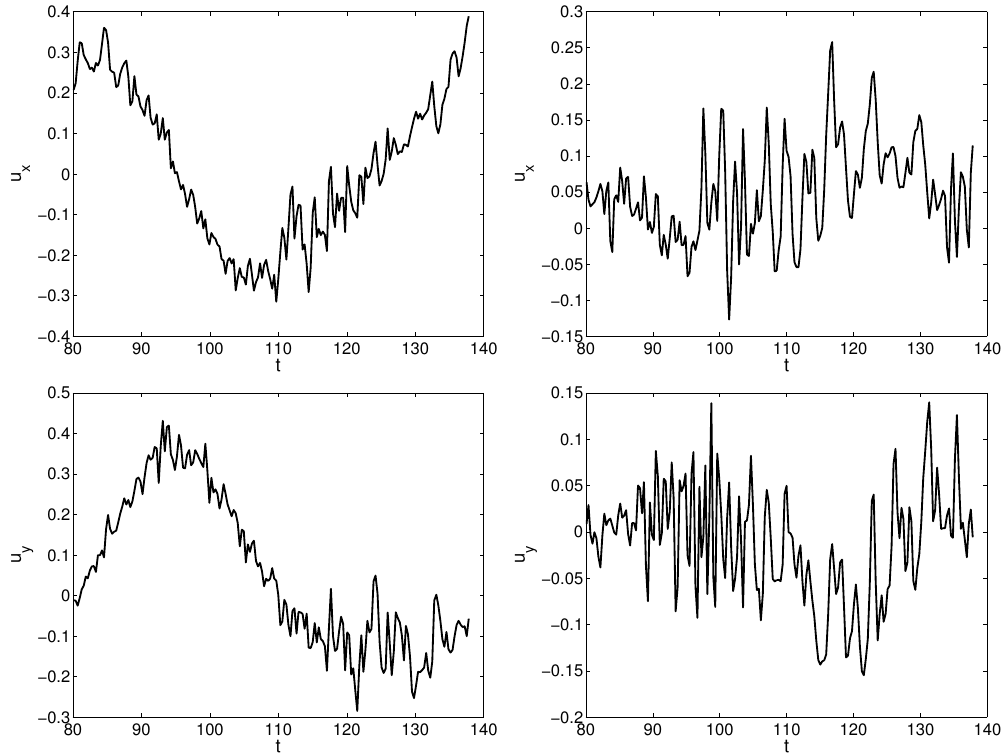
Figure 9. Counterpart of Figure 4 in the three-blades turbine in points P ( x 1 , y 1 ) = ( 0, − 4 ) ( left ) and √ √ P ( x 1 , y 1 ) = ( 2 2,2 2 ) ( right